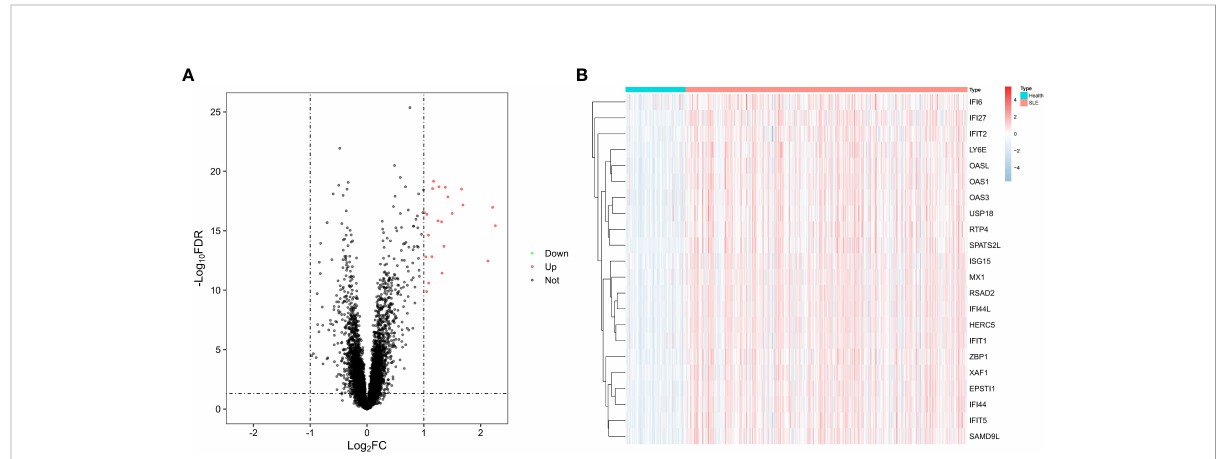
FIGURE 2 Differential genes. (A) Volcano diagram with 22 genes with signi fi cant differences, red dots indicate up-regulated genes, black dots indicate non-differentiated genes, and green dots indicate down-regulated genes. (B) Heat map of 22 differential genes with upregulation